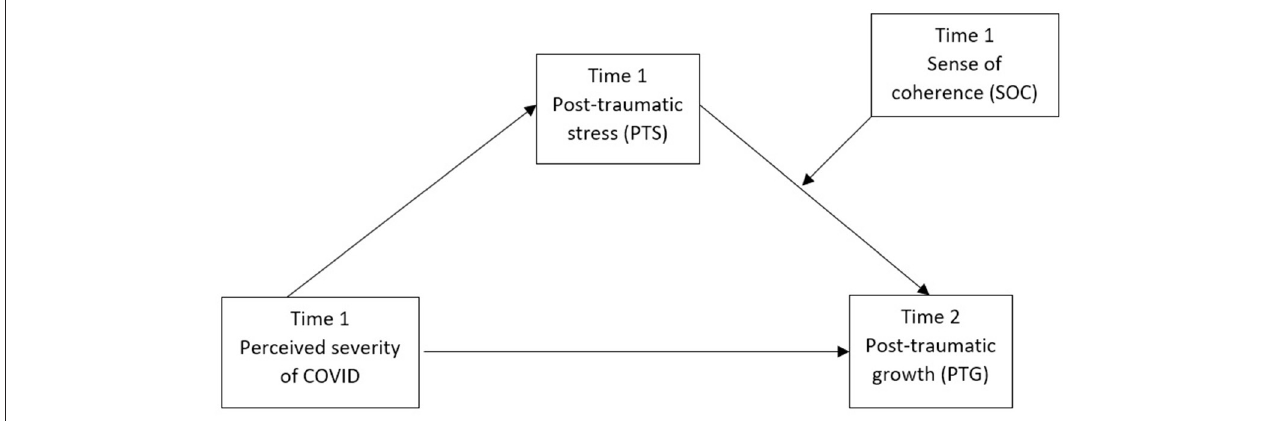
FIGURE 1 | Schematic diagram of the moderated mediation model on the emergence of post-traumatic growth at Time 2 from perceived severity of COVID at Time 1 through a combination of high post-traumatic stress and high sense of coherence.